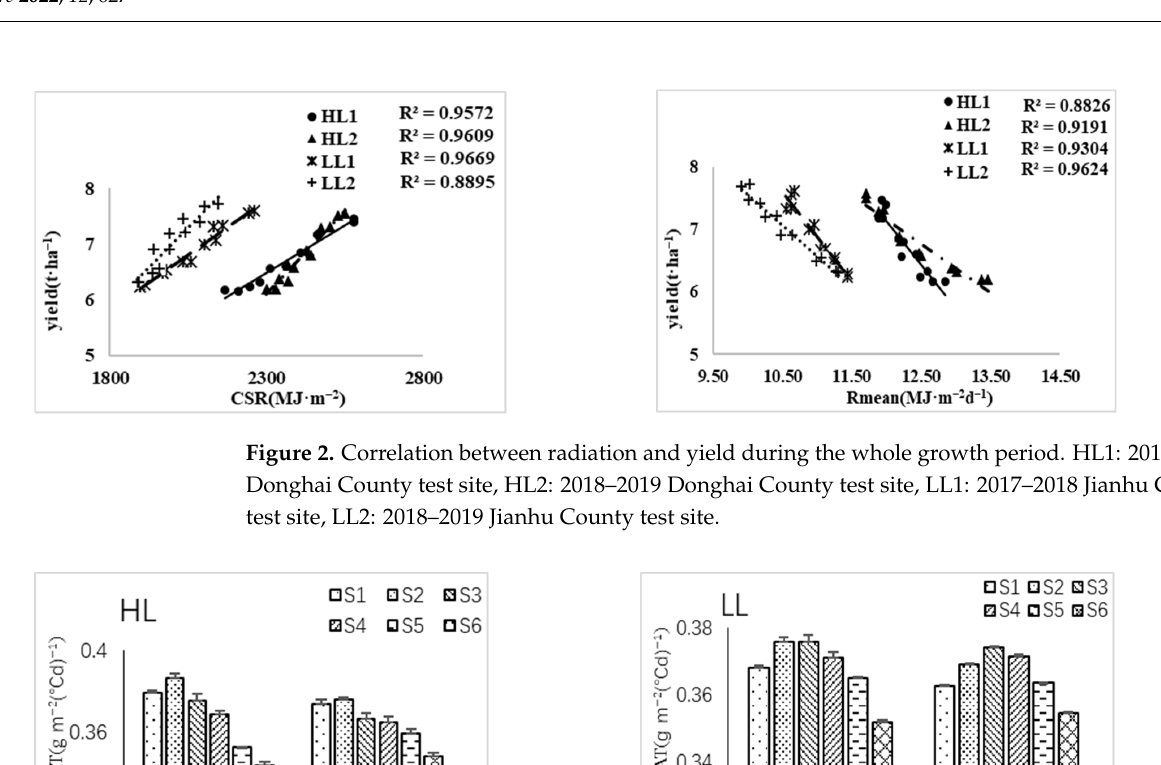
Figure 1. Correlation between temperature and yield during the whole growth period. HL1: 2017–